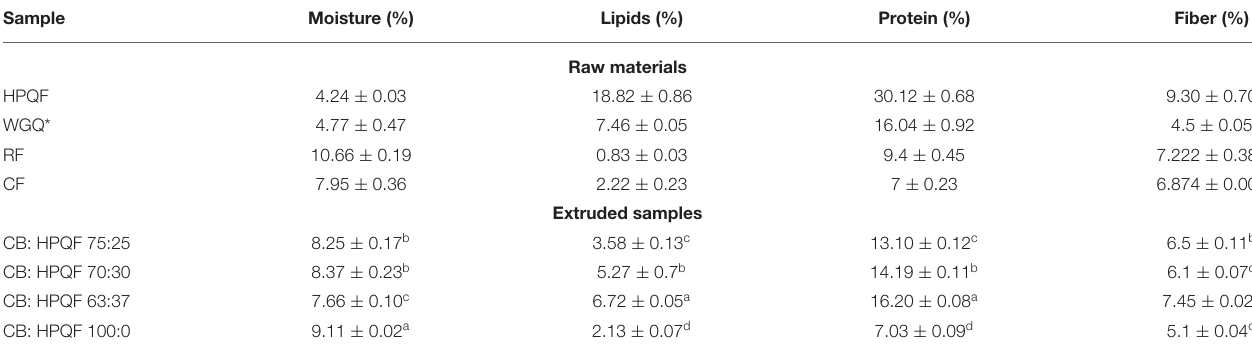
TABLE 2 | Quantification of moisture, lipids, and protein of raw materials for the validation of hyper-protein flour. Sample